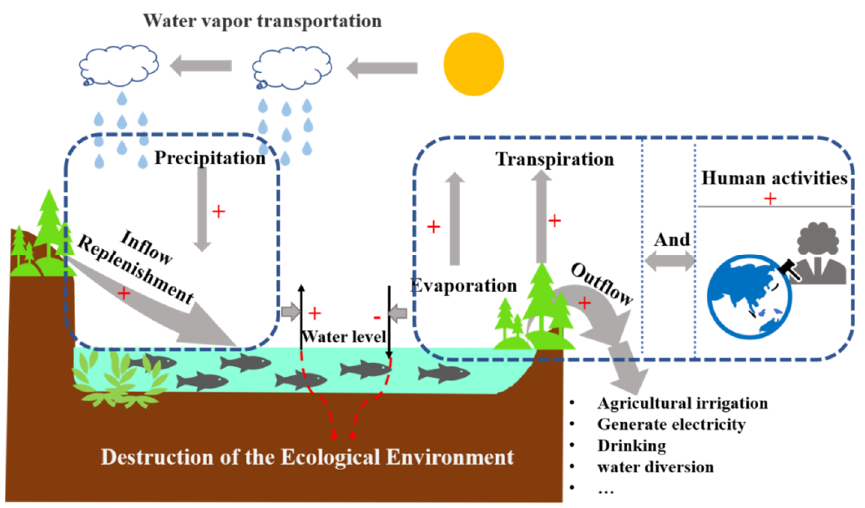
Figure 9. Mechanism of the variation of the water level in the lake. In the figure, “+” is for increase; “–” is for decrease.